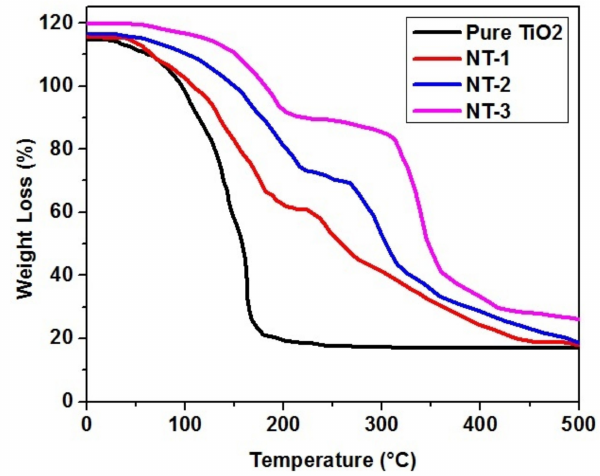
Figure 5. TGA curves for pure TiO 2 , NT-1, NT-2 and NT-3, synthesized by using 0.0, 0.983, 1.965 and 2.940 g of urea,